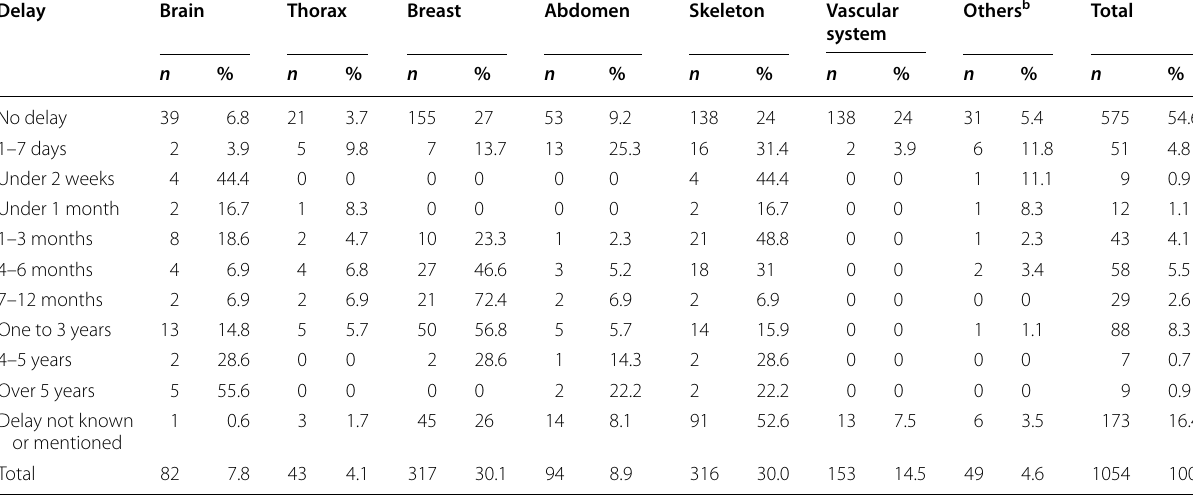
Table 2 Diagnosis delay by studied anatomical organs assessed by PVKª